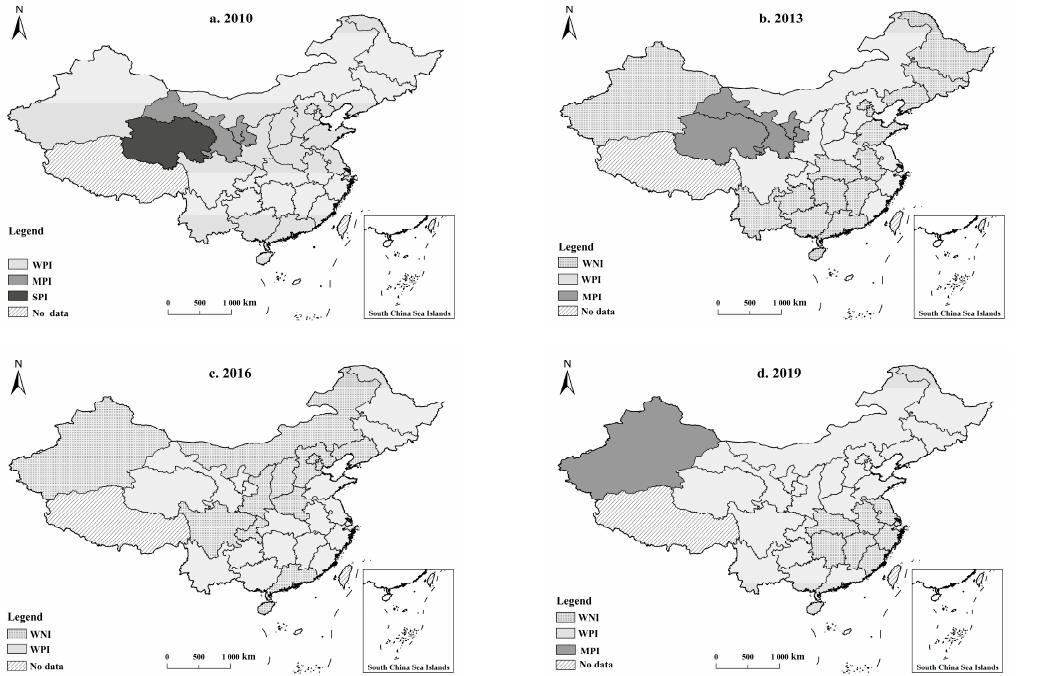
Figure 7. Spatial distribution of the regression coefficients of the green building index: ( a ) Spatial distribution of the regression coefficients of the green building index in 2010; ( b ) Spatial distribution of the regression coefficients of the green building index in 2013; ( c ) Spatial distribution of the regression coefficients of the green building index in 2016; ( d ) Spatial distribution of the regression coefficients of the green building index in 2019.